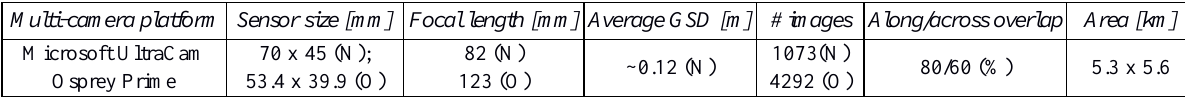
Table 1. Camera and dataset specifications. N and O stand for nadir and oblique. The given overlap is calculated on the nadir images.